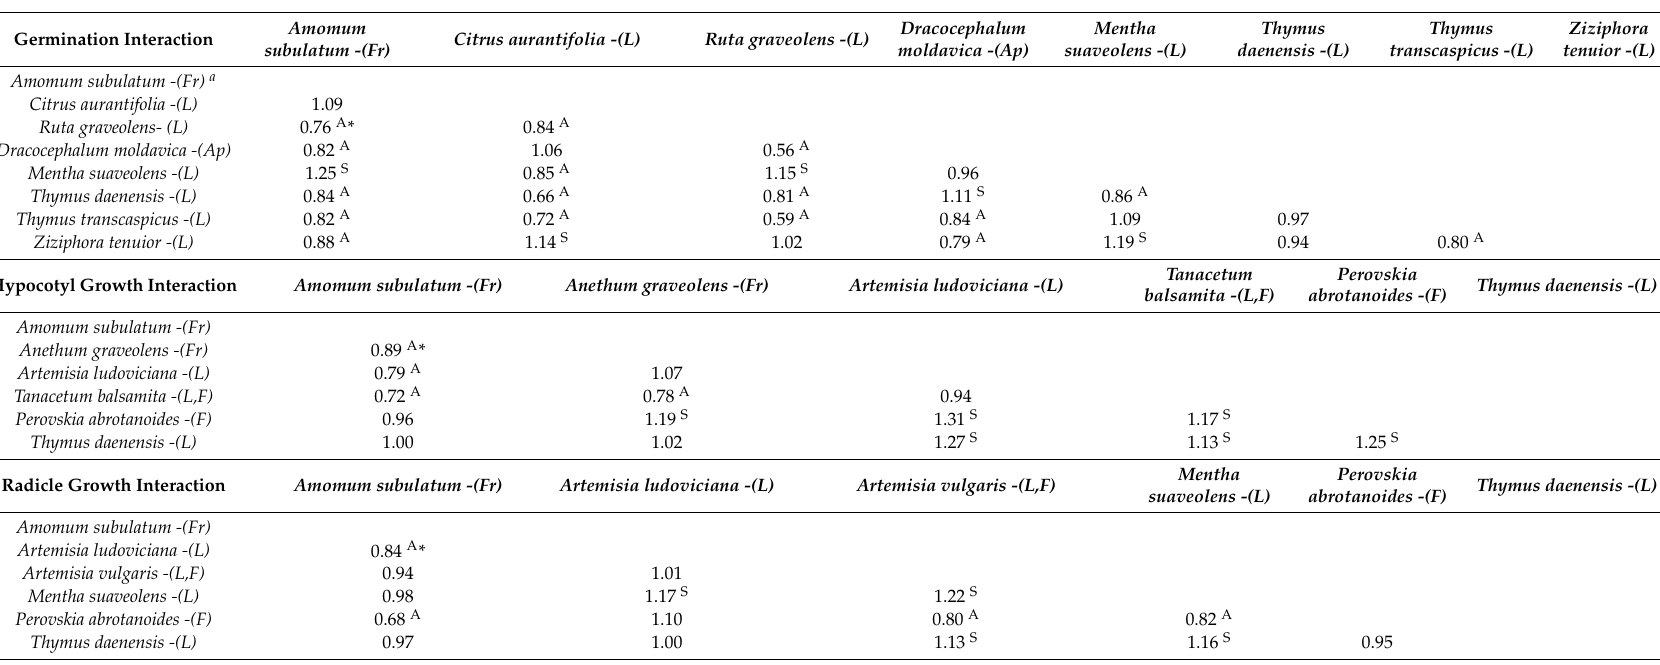
Table 5. Allelopathic e ff ects of essential oils mixtures on seed germination, hypocotyl and radicle growth of lettuce based on simplified modified dilution check-board technique (SMCT) by cotton swab